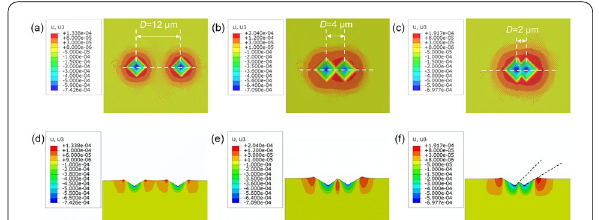
Figure 4 Top views of the simulated results for the two adjacent indentations with the rotation angle of 0° and the spacings of a 12 μm, b 4 μm and c 2 μm; Side views of the simulated results for the two adjacent indentations with the rotation angle of 0° and the spacings of d 12 μm, e 4 μm and f 2 μm